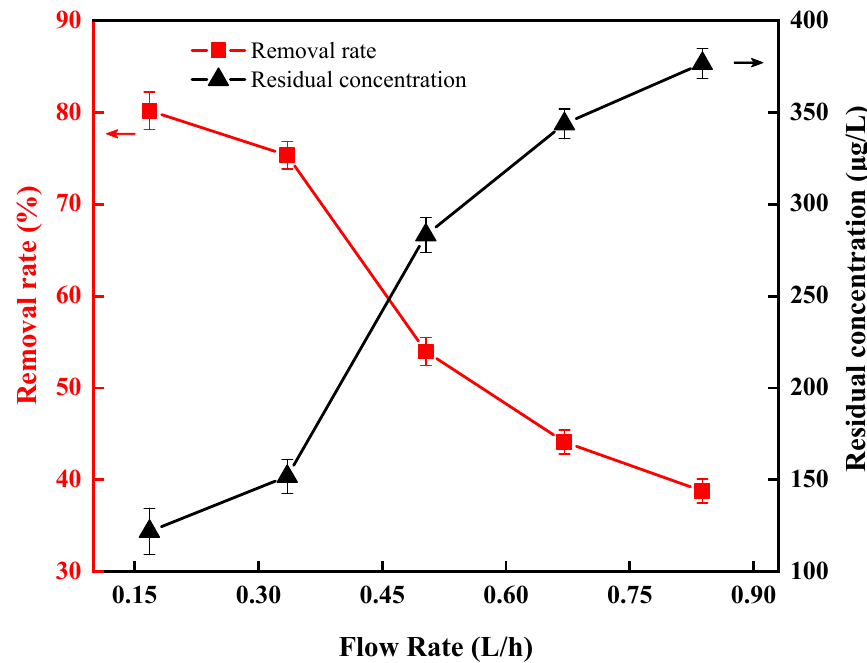
Figure 10. Effect of flow rate on direct removal of Anabaena by DEP.